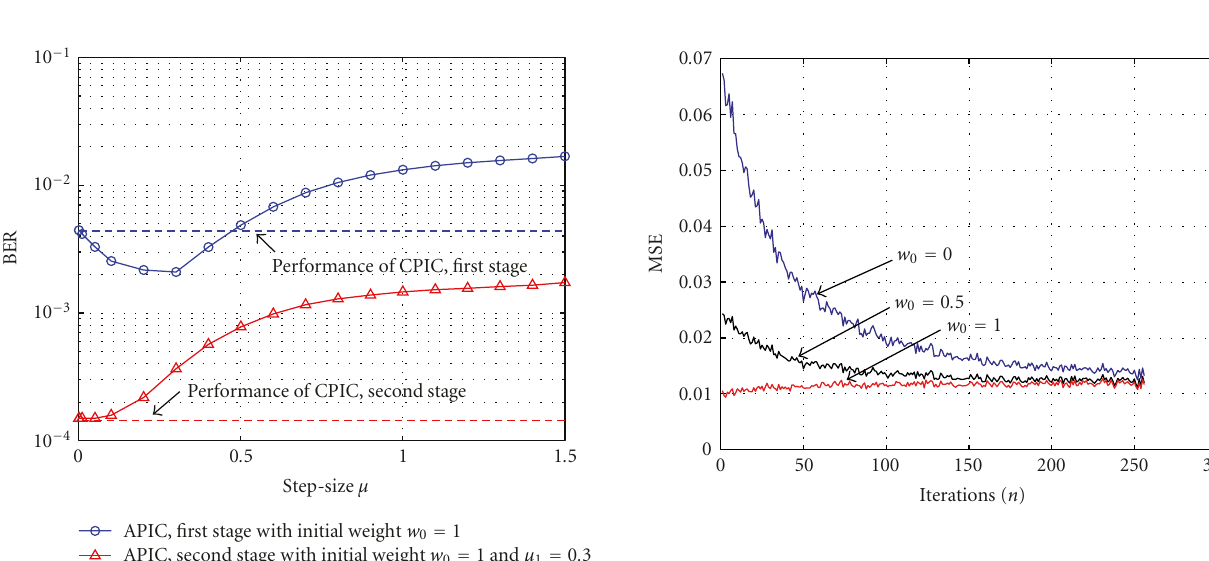
Figure 9: Convergence comparison for di ff erent initial weights. N = 32, K = 30, SNR = 20 dB, μ = 0 .